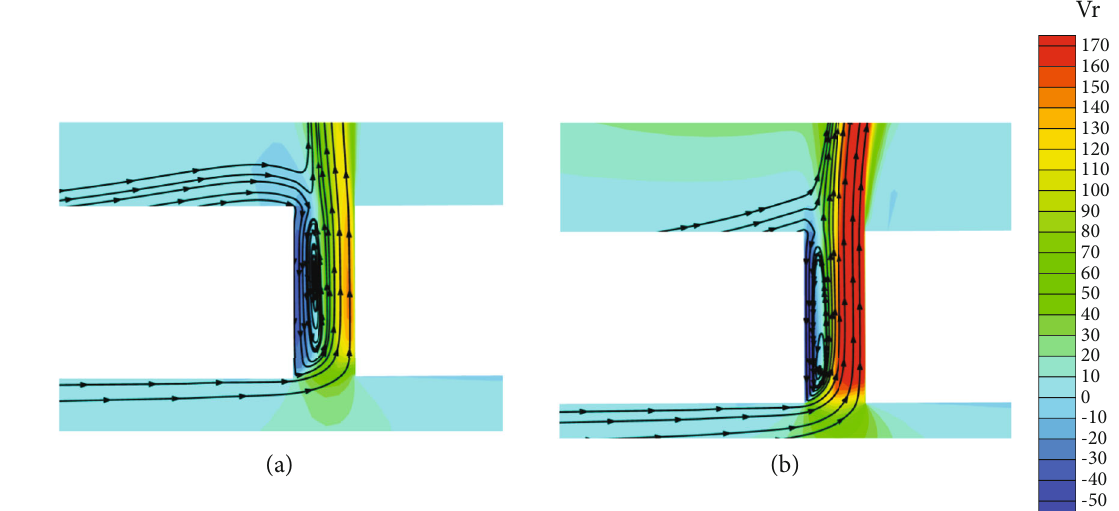
Figure 10: Flow in slot with (a) low and (b) high bleed